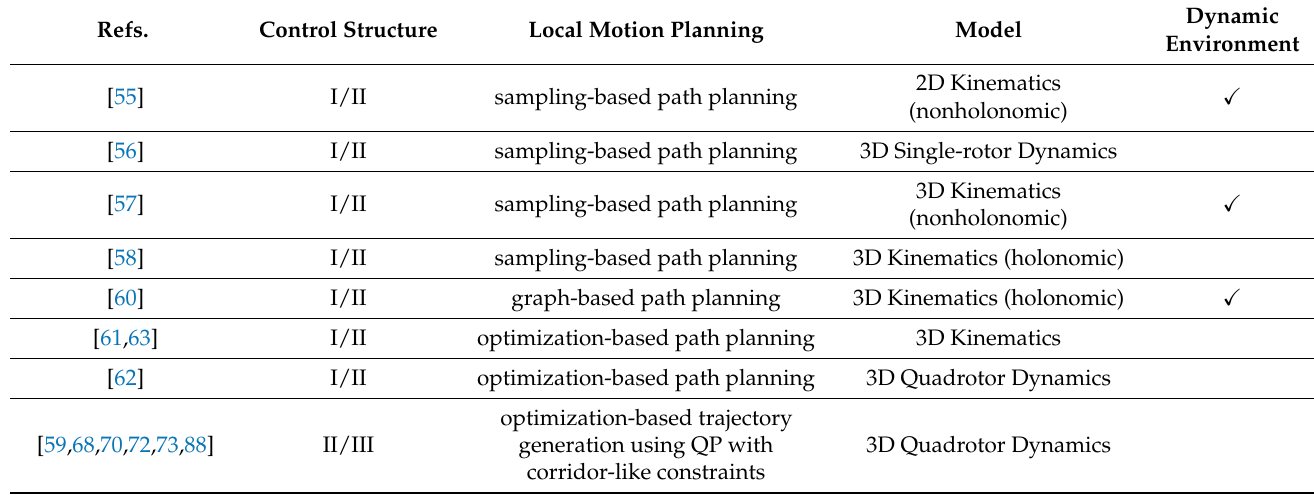
Table 1. A summary of surveyed local motion planning methods for UAVs.